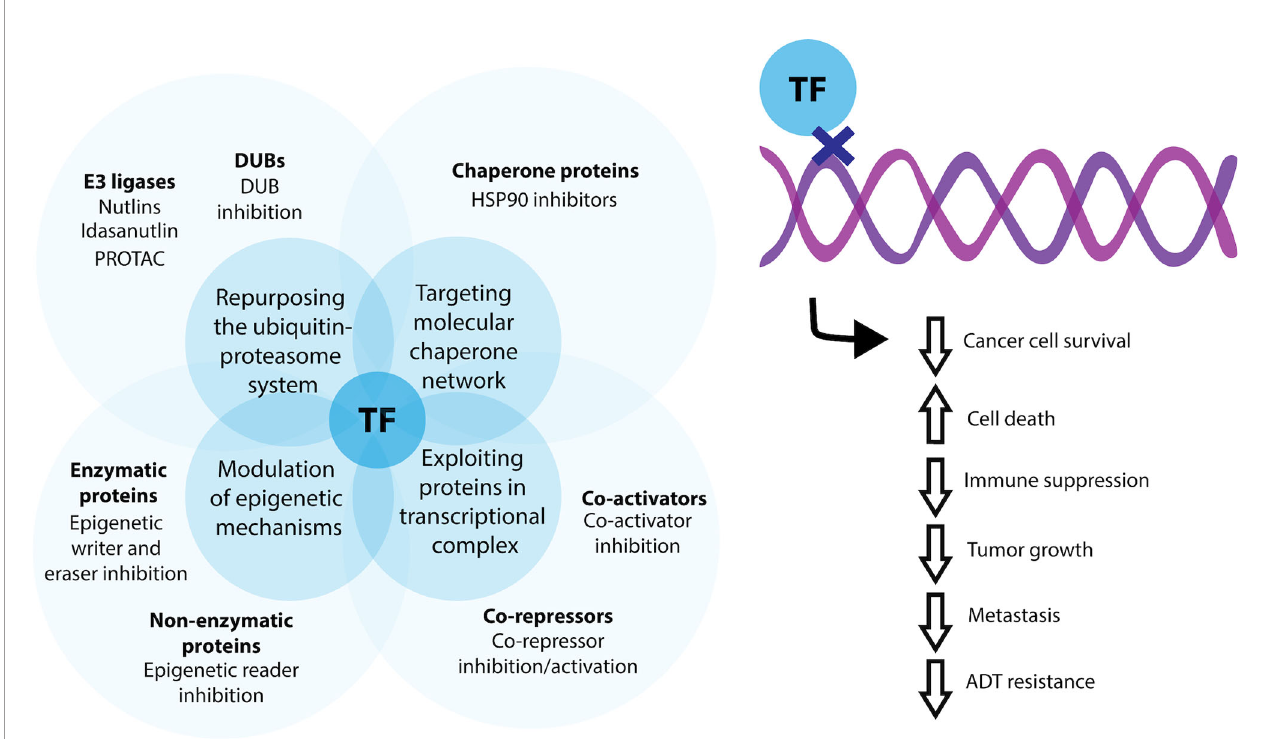
FIGURE 1 | Current indirect methods for targeting transcription factors for prostate cancer therapy. Transcription factor (TF) activity may be indirectly modulated by targeting enzymatic and non-enzymatic proteins involved in epigenetic signaling, through repurposing and manipulating aspects of the ubiquitin-proteasomal system for control of transcription factor degradation, by targeting the molecular chaperone network and by exploiting co-activator and co-repressors associated with a transcriptional complex. Using these methods, transcription factor activity can be favorable modi fi ed to decrease cancer cell survival, overall tumour growth and the potential for metastatic